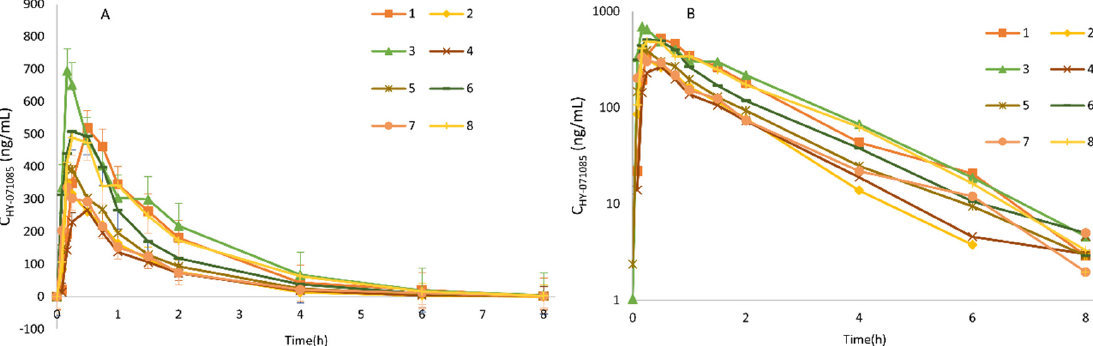
Figure 10. Plasma concentration–time curve of HY-071085 after the continuous repeated-dose intra- gastric of 2.5 mg/kg in beagle dogs. ( A ) Constant coordinates; ( B ) semilogarithmic coordinates.